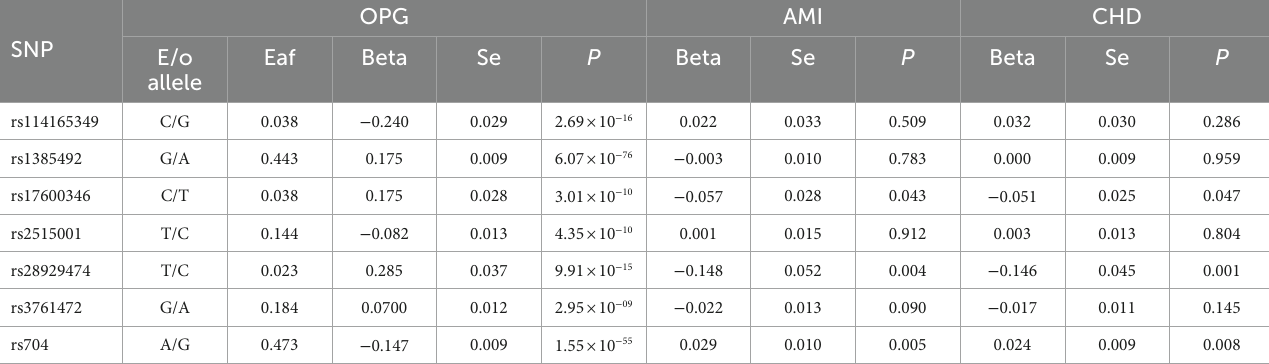
TABLE 1 Genome-wide significant single nucleotide polymorphisms (SNPs) for OPG levels and their association with AMI and CHD.